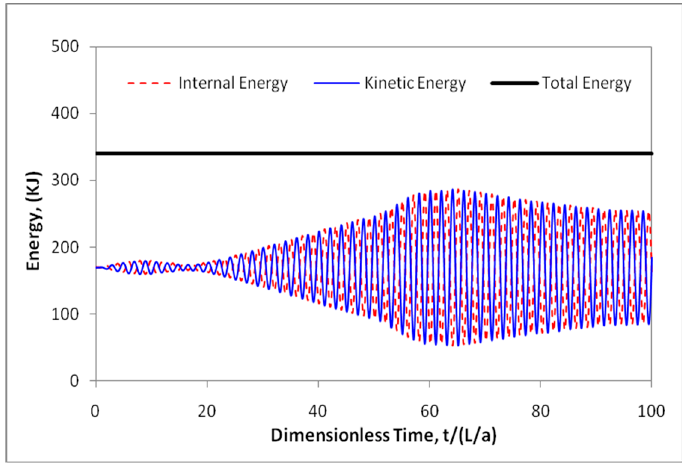
Figure 14. Energy results of transient wave scattering along the pipeline.